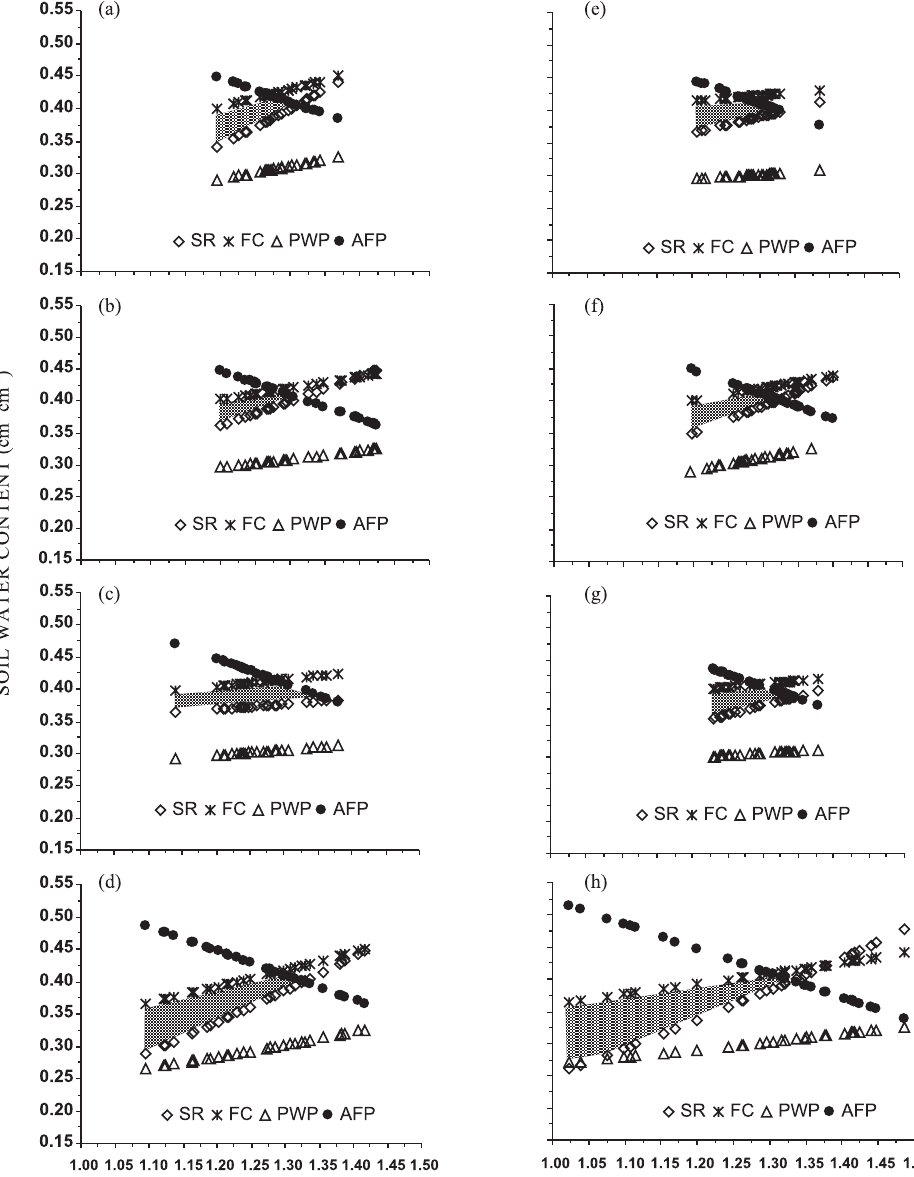
Figure 3. Soil water content ( θθθθθ ) as affected by soil bulk density, at the critical levels of field capacity (FC = -0.01 MPa), permanent wilting point (PWP = -1.5 MPa), air-filled porosity (AFP = 10 %) and soil penetration resistance (SR = 2MPa). Samples collected in the 0–20 cm layer, in the third year of the experiment. The shaded area represents the LLWR. (a) sunflower+millet; (b) sunflower+forage sorghum; (c) sunflower+sunn hemp; (d) sunflower+chiseling; (e) triticale+millet; (f) triticale+forage sorghum; (g) triticale+sunn hemp; (h)